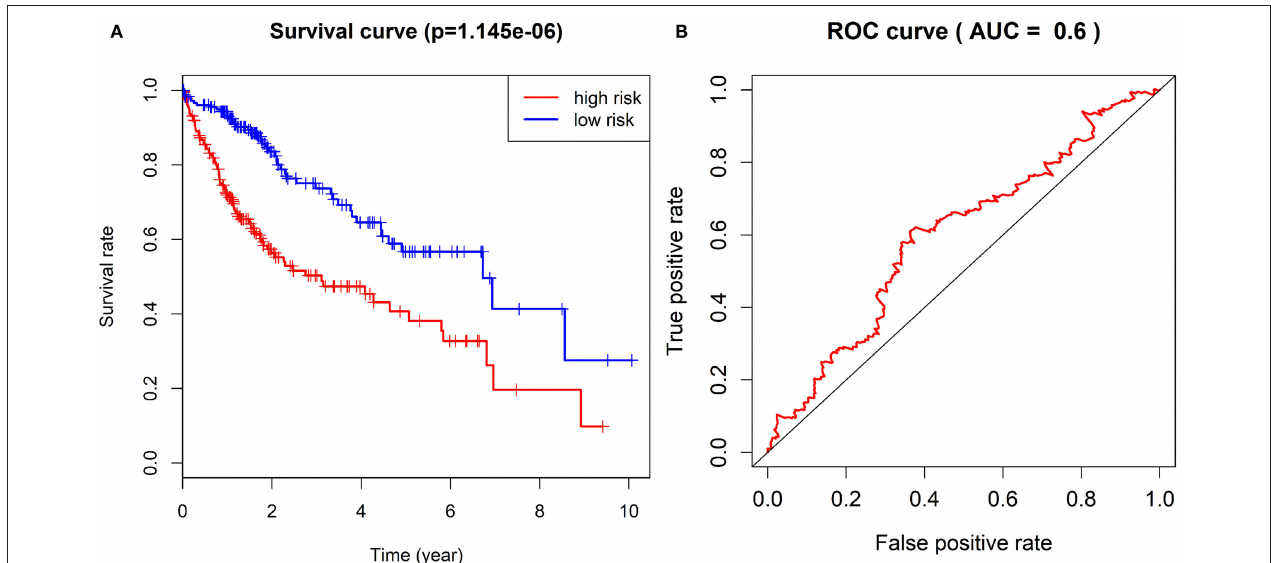
FIGURE 10 | Survival curve of patients with HCC in TCGA-LIHC cohort in the high-risk group and the low-risk group and ROC curve for evaluation of the prognostic risk model. (A) , The difference of survival rate between the high-risk group and the low-risk group by Kaplan-Meier survival analysis. (B) , The sensitivity and specificity of ROC curves to show risk score in evaluating